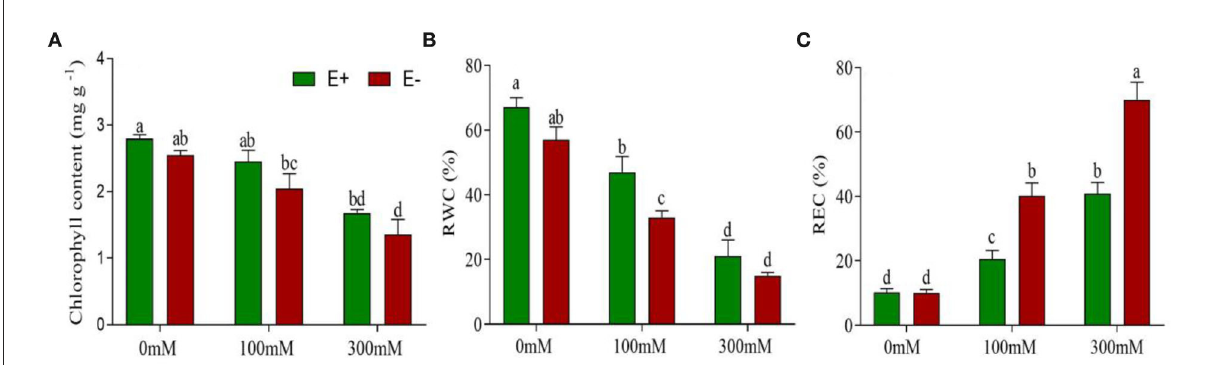
FIGURE2 Epichloë bromicola increases the leaf chlorophyll content, RWC, and decreases the REC in barley under salt stress conditions. Chlorophyll contents (A) , RWC (B) , and REC (C) of barley inoculated with E. bromicola and subjected to NaCl concentrations of 0, 100, and 300mM (values are means ± SE). Green bars represent E + barley, and red bars represent E– barley. Measurements were carried out after 21 days of plant growth under salt stress. Different letters indicate significance at a p -value < 0.05 among treatments (Tukey’s